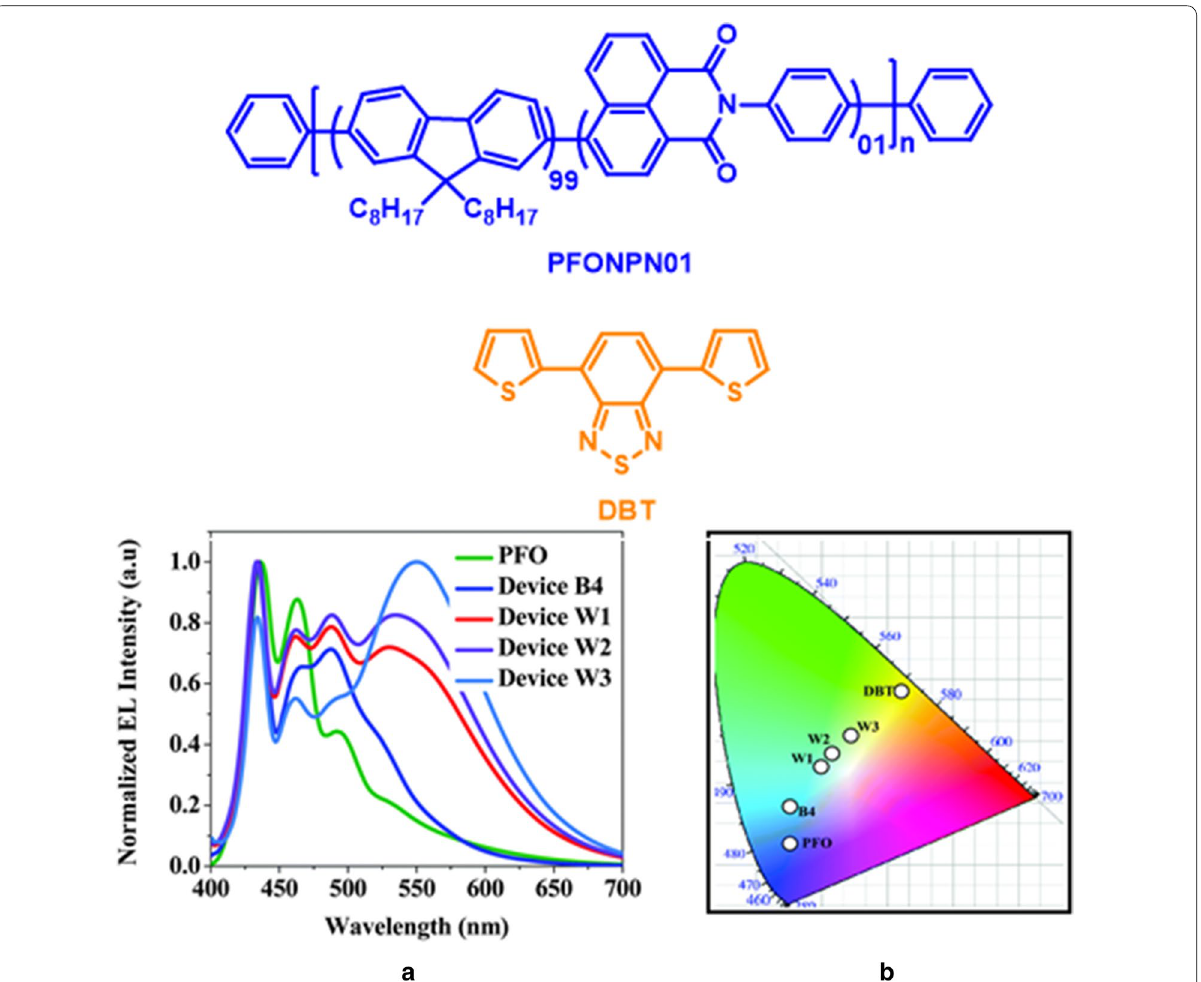
Fig. 3 Molecular structures of PFONPN01 and DBT. a EL spectra and b CIE coordinate diagram of devices (B4-PFONPN01, W1, W2, and W3 with DBT ratio of 0.2%, 0.4% and 0.6%, respectively) (Reproduced with permission from Ref. [18] Copyright 2016, ©Physical Chemistry Chemical